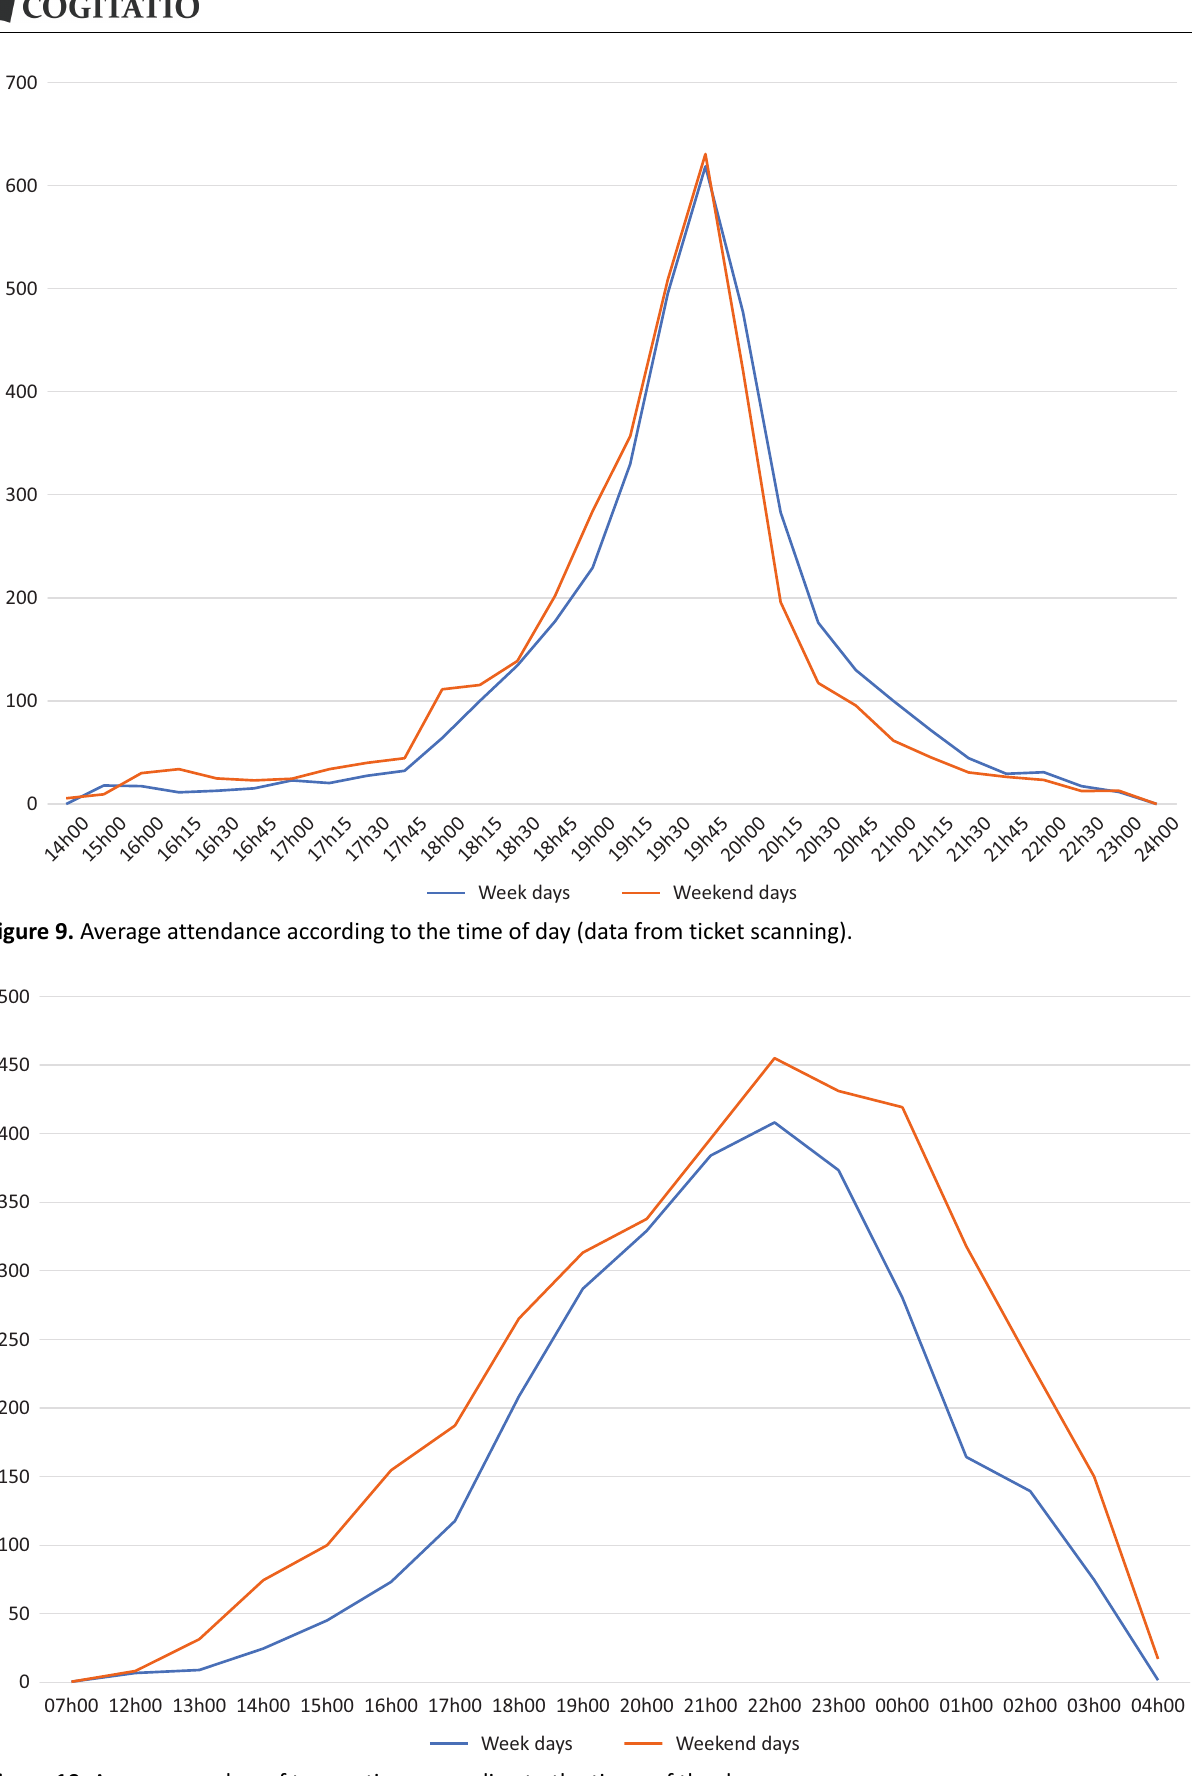
Figure 10. Average number of transactions according to the times of the